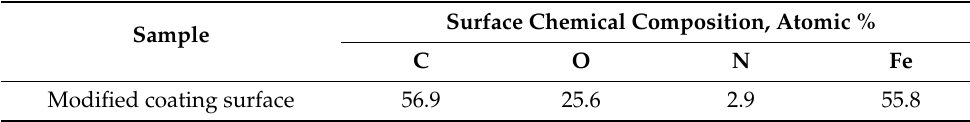
Figure 9. XPS analysis of surface after coating removal , High resolution spectra of ( a ) C 1s, ( b ) O 1s, ( c ) Fe 2p 3/2 , ( d ) N 1s. Table 2. Surface elemental composition of surface of XPS